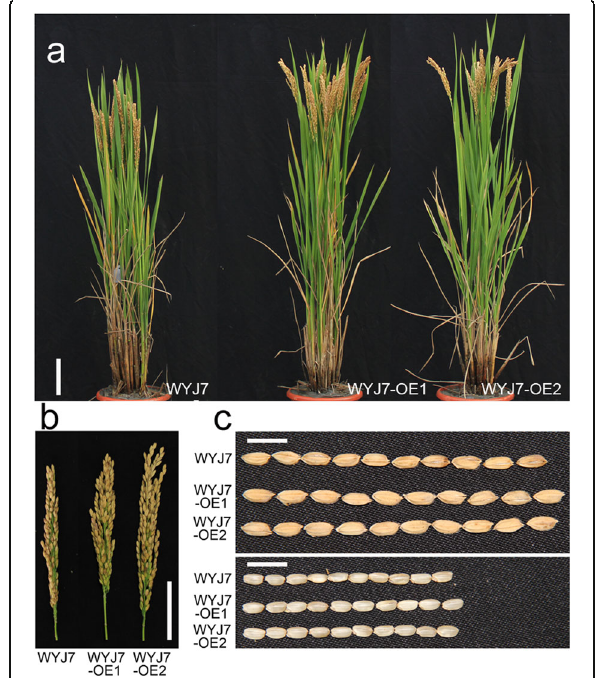
Fig. 7 Plant morphology, panicle architecture and grain size of GNS4 - overexpressing lines in high-yield variety Wuyunjing 7 (WYJ7) background. a Mature plant appearance of WYJ7 and the transgenic lines. Bar, 10 cm. b Panicle architecture of WYJ7 and the transgenic lines. Bar, 5 cm. c Comparisons of grains (top) and brown rice (bottom) between WYJ7 and the transgenic lines. Bars, 1 cm. WYJ-OE1 and WYJ-OE2 are two independent GNS4 -overexpressing